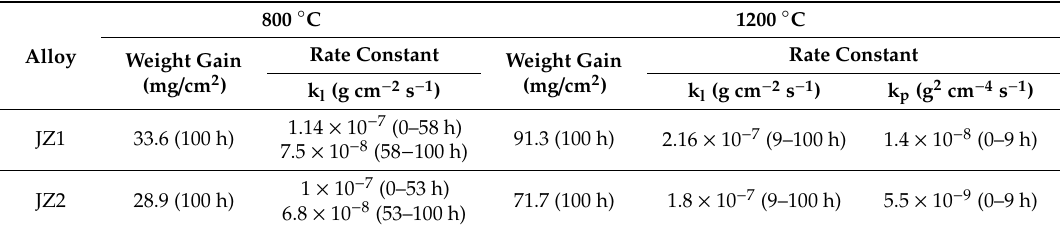
Table 4. Weight gains and oxidation rate constants of the alloys JZ1 and JZ2 after isothermal oxidation at 800 and 1200 ◦ C for 100 h.